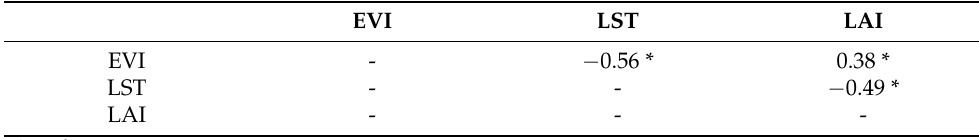
Table 1. R values for the correlations of each two indices for all counties. The correlations were the r values between each satellite-derived index during the peak GS and corn yield in each county (right panels in Figure